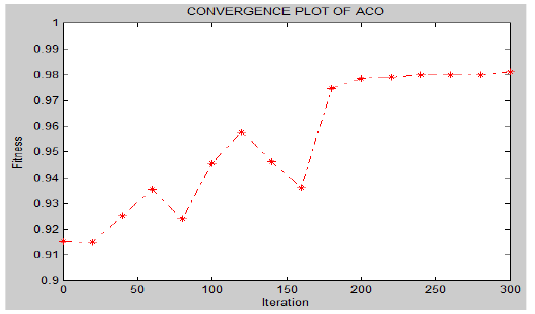
Figure 2. Convergence Plot of Fitness Value in ACO Figure 3. Influence Over Number of Iterations on